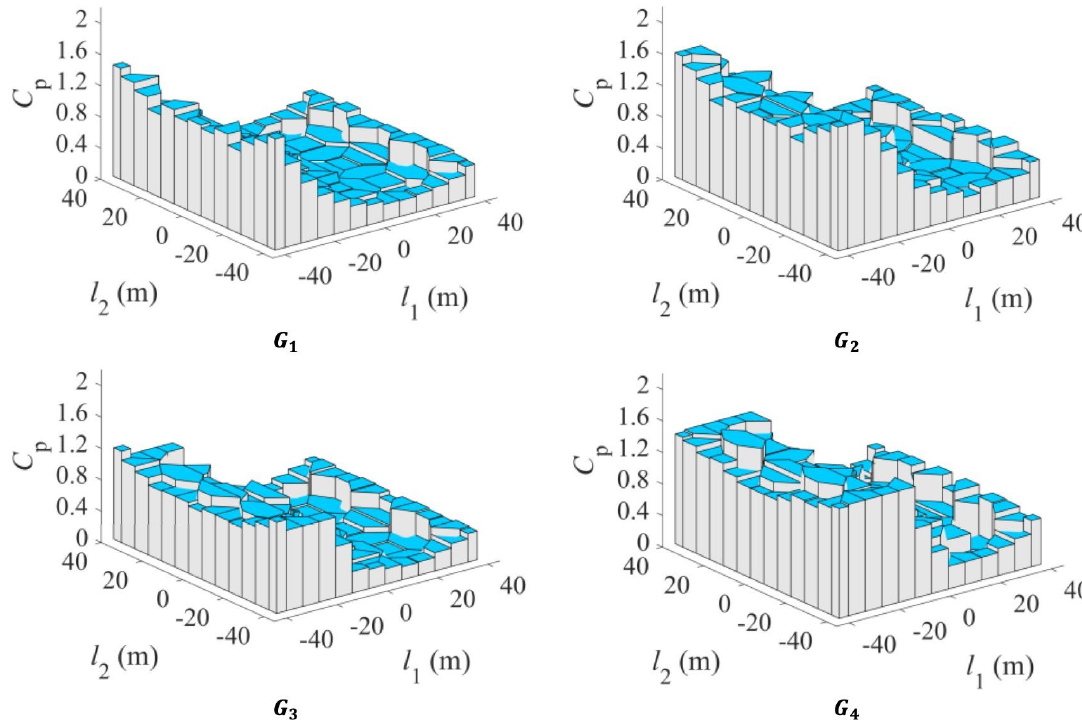
Figure 4: Mean pressure coeflcients of square plan geometries with θ = 90 ∘ [16]